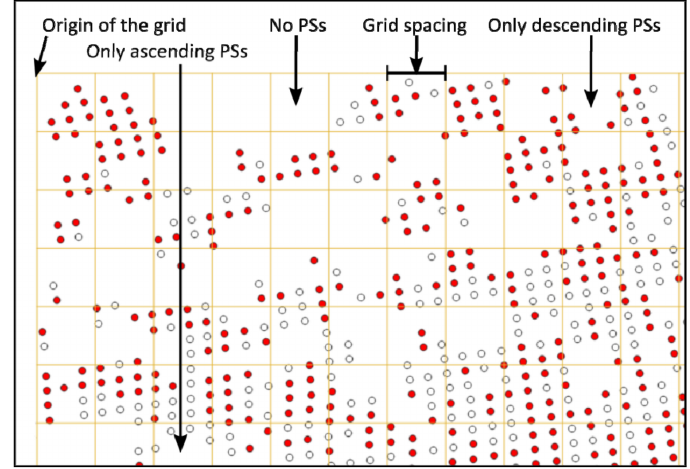
Figure 9. los2v: tesserae and ascending and descending persistent scatterers (PS). The white points represent the PS in ascending orbit; the red points the PS in descending orbit. Source: